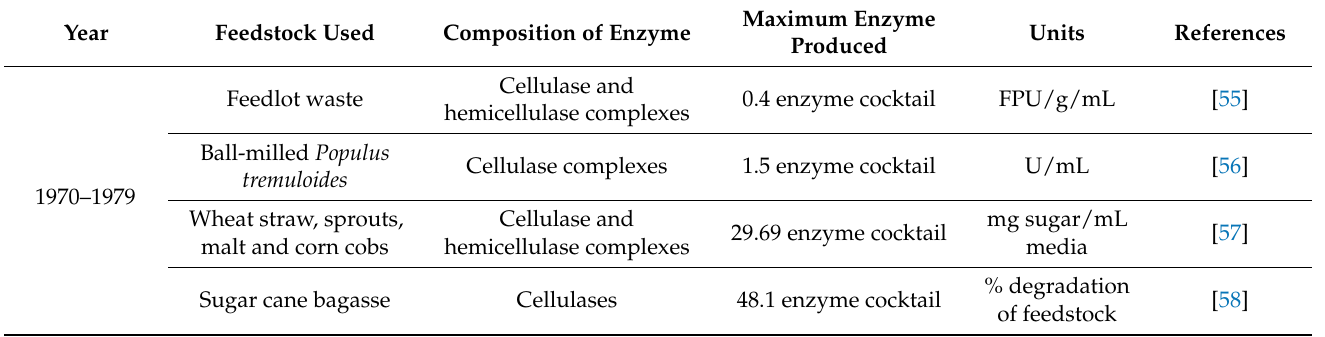
Table 2. The feedstock analysis for the production of hydrolytic enzymes